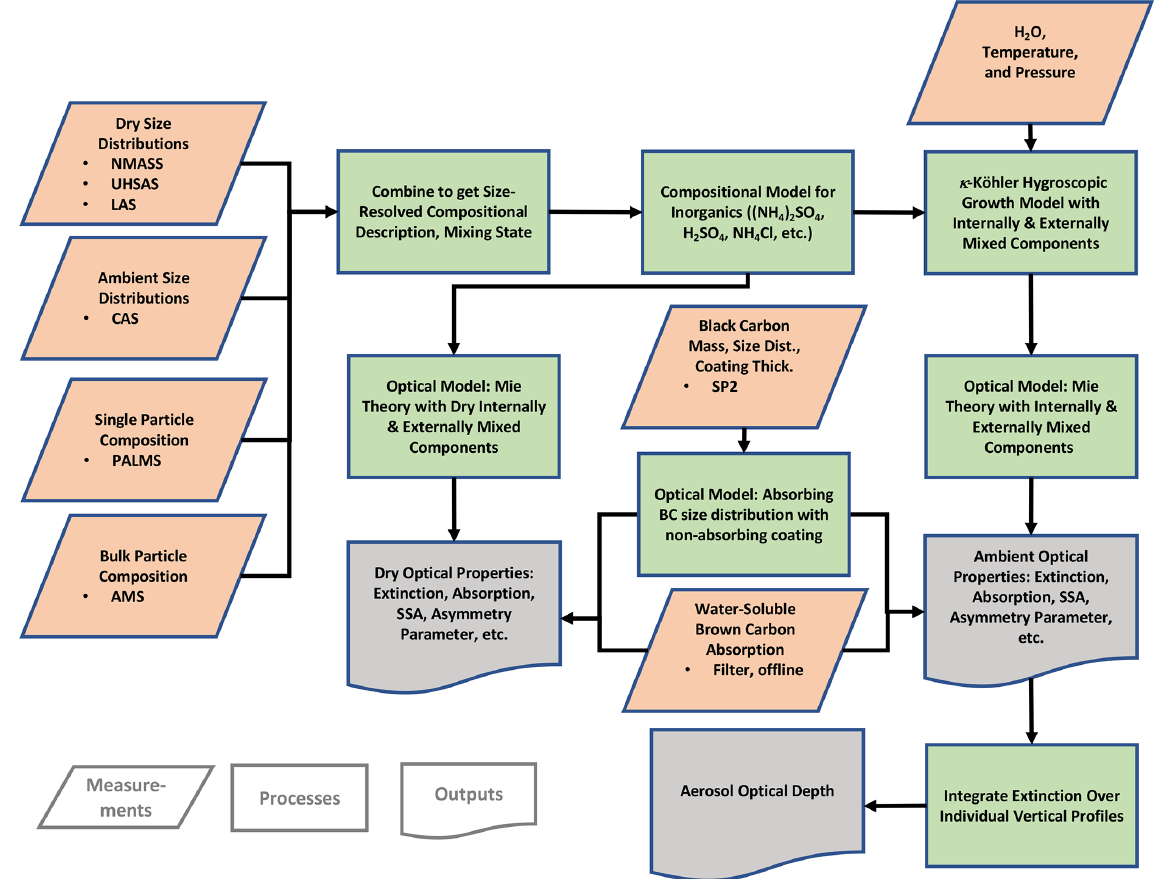
Figure 2. Schematic showing how data from instruments that measure size distribution, particle composition, and meteorological parameters are combined to form a self-consistent description of the composition-dependent size distribution. Compositional, hygroscopic growth, and optical models are combined to determine dry and ambient aerosol optical properties and AOD.